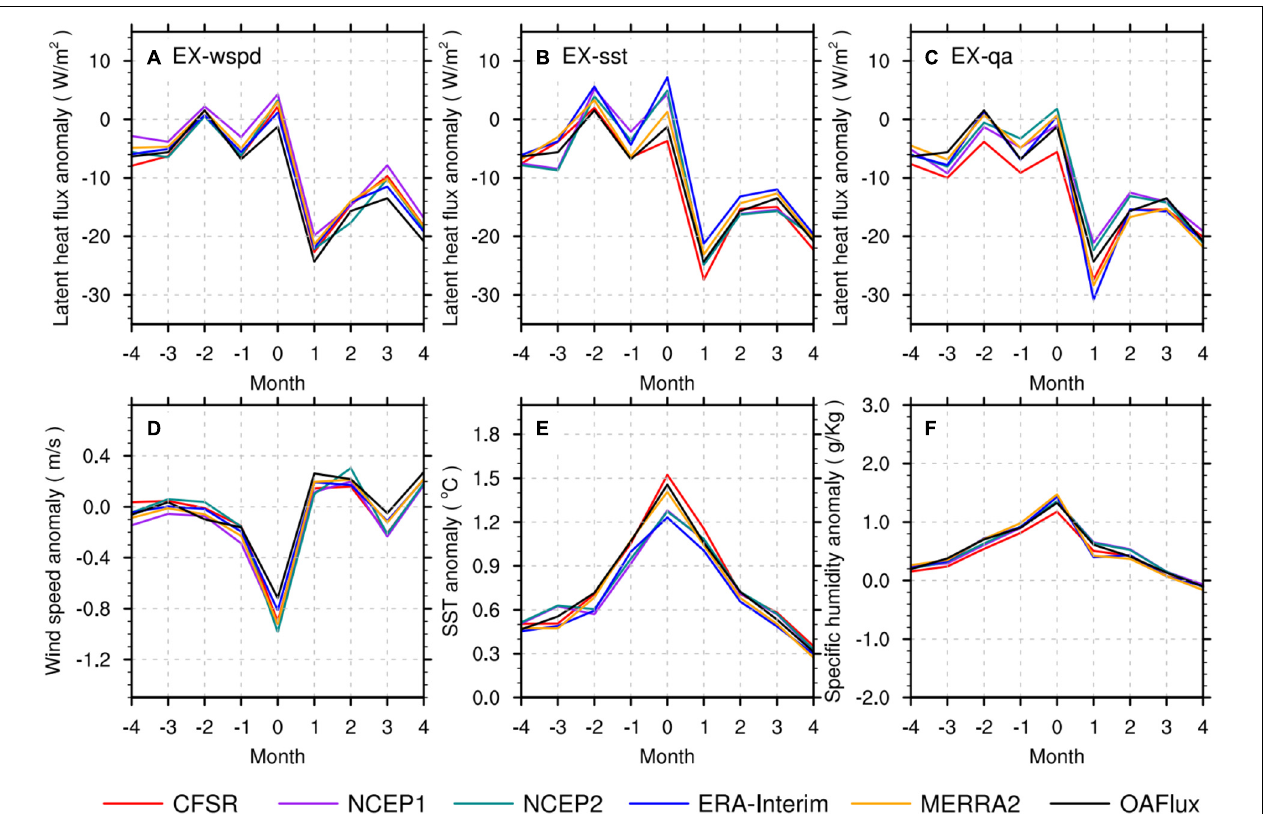
FIGURE 9 | The top row: The composites of monthly heat flux anomalies over the region (110 ◦ E-116 ◦ E, 22 ◦ S-32 ◦ S) from (A) EX-wspd, (B) EX-sst and (C) EX-qa. Positive values indicate the warming of the ocean. The bottom row: The wind speed anomalies (D) , SST anomalies (E) , and specific humidity anomalies (F) from the reanalysis